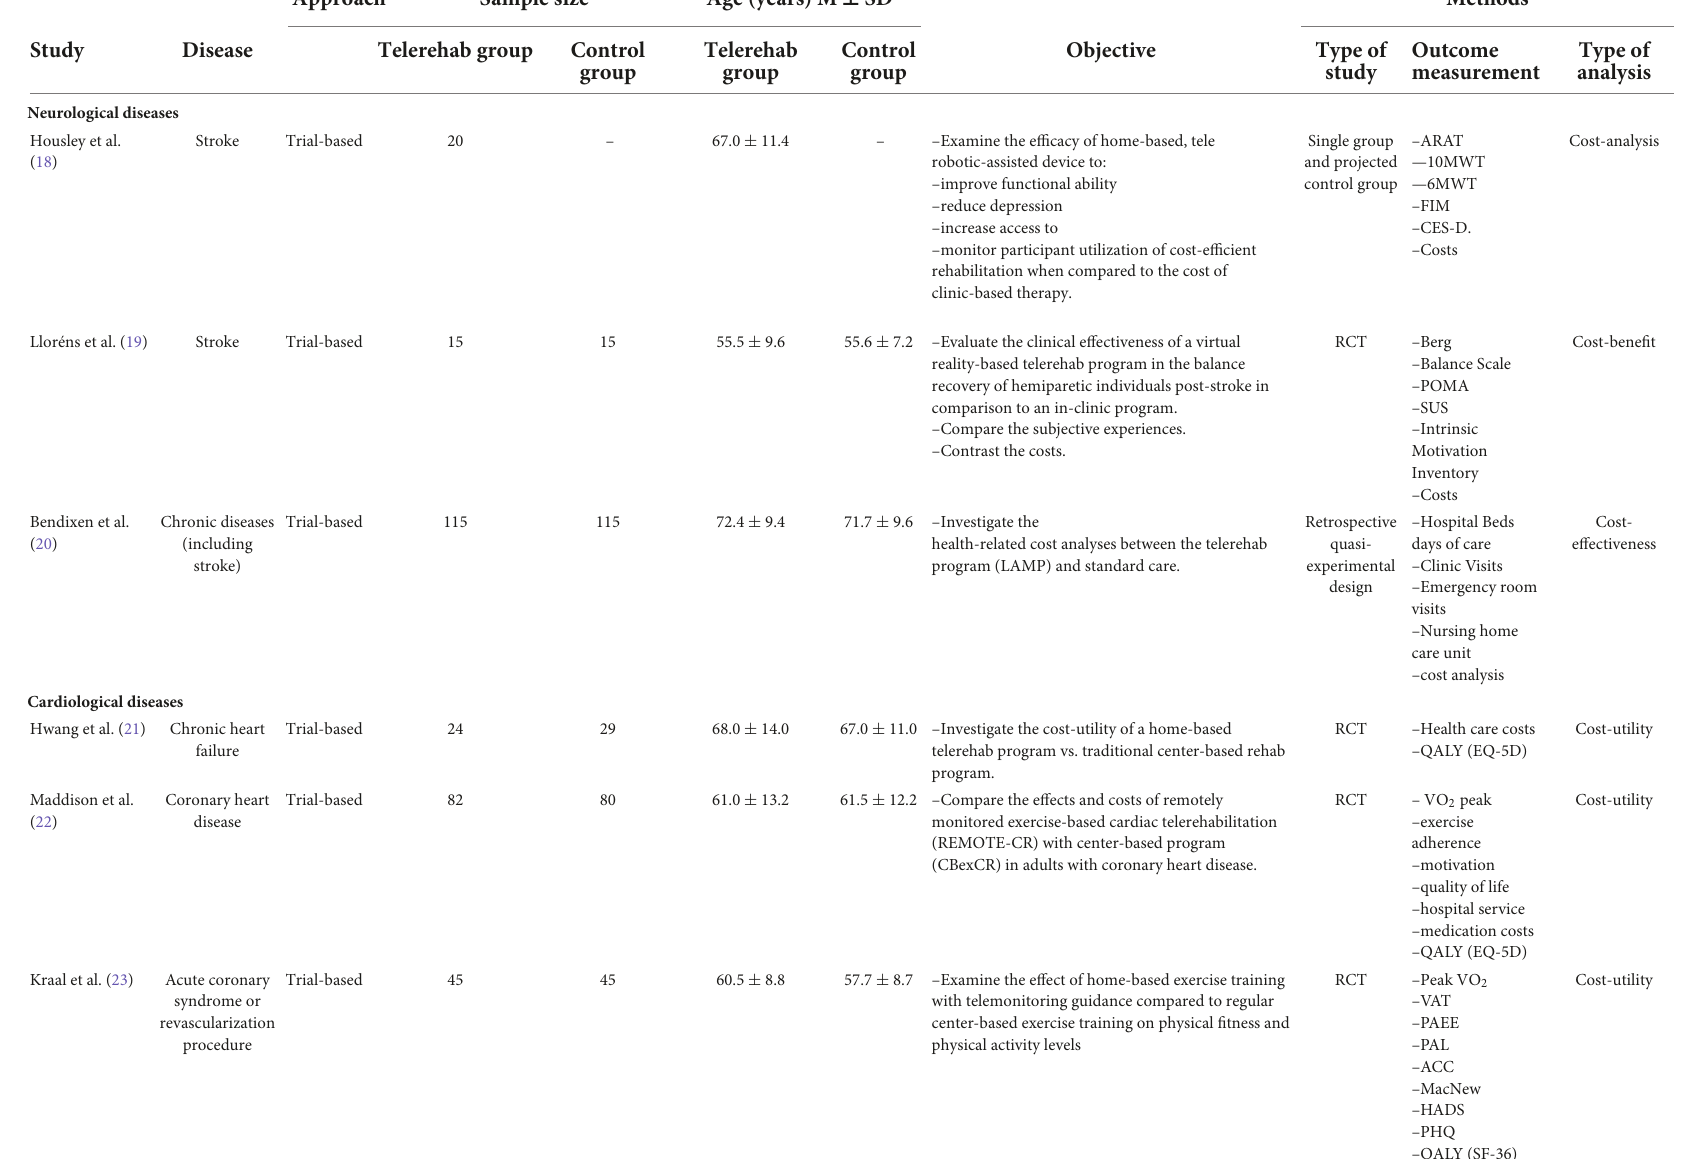
TABLE 1 Summary of study